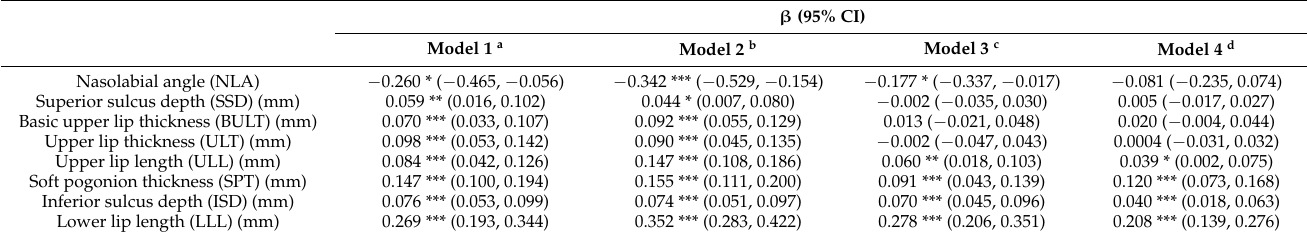
Table 3. Association of BMI with upper and lower lip characteristics by multivariate